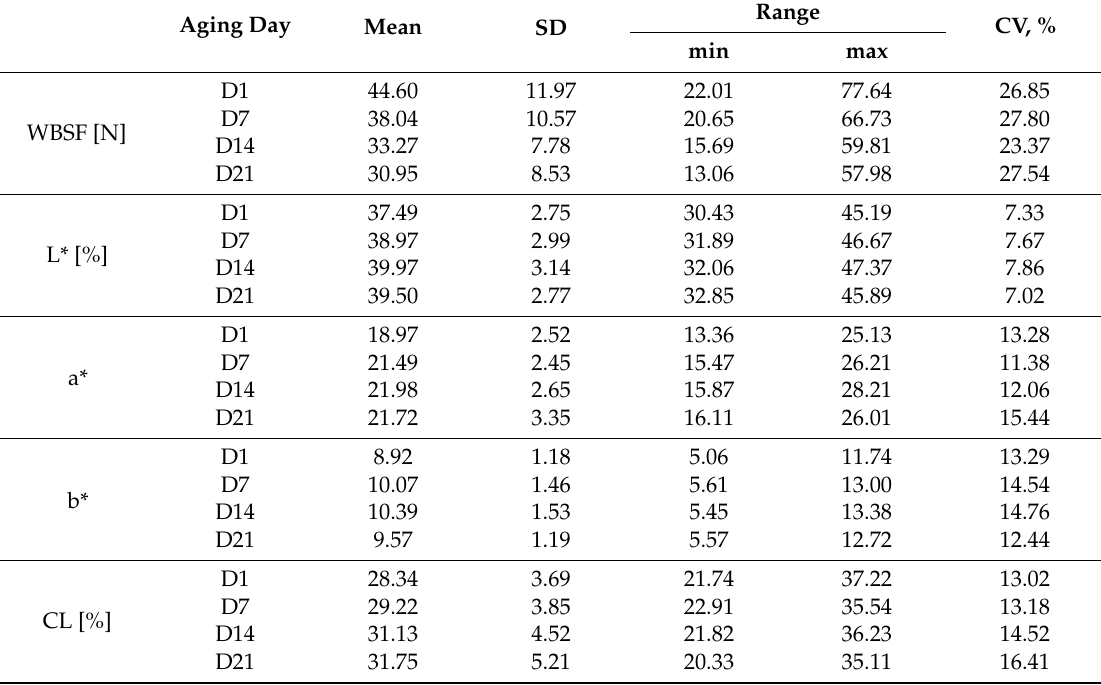
Table 2. Reference values of Warner–Bratzler shear force (WBSF), color (L*, a*, b*), and cooking loss (CL) of beef LL muscle measured by traditional methods (N = 178 for each aging